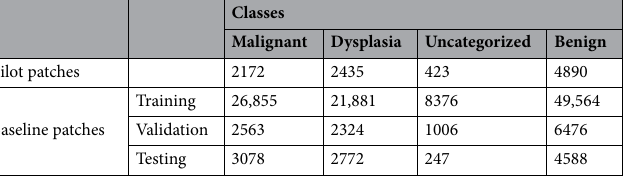
Table 3. Information about the number of patches for each data split based on stomach whole-slide